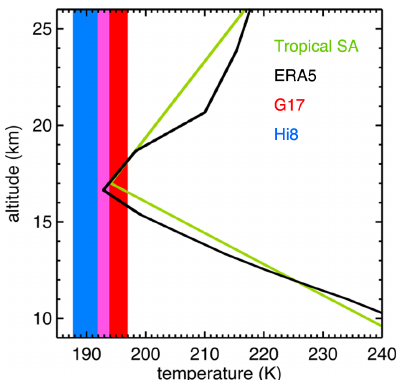
Figure 12. The ERA5 temperature profile (black line), a tropical standard atmosphere temperature profile (green line), and the range of the GOES-17 and Himawari-8 minimum BT 11 between 05:50– 07:50UTC (red and blue shaded areas, overlap in magenta) for the 26 June 2019 eruption of